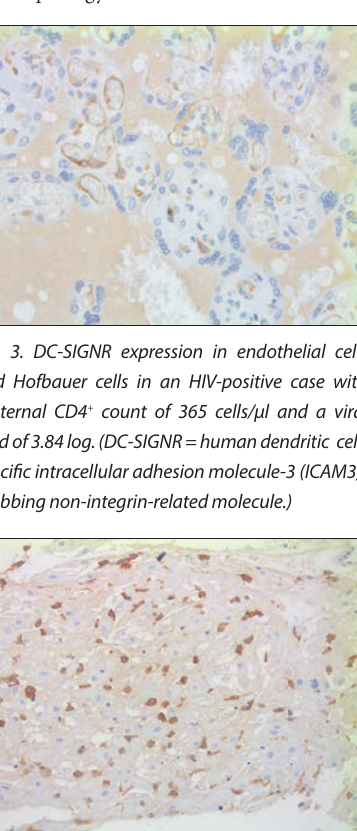
Fig. 2. DC-SIGN expression in decidual macrophages in an HIV-positive case with the only detectable viral load in the cord blood. (DC- SIGN = human dendritic cell-specifi c intracellular adhesion molecule-3 (ICAM3)-grabbing non- integrin.)